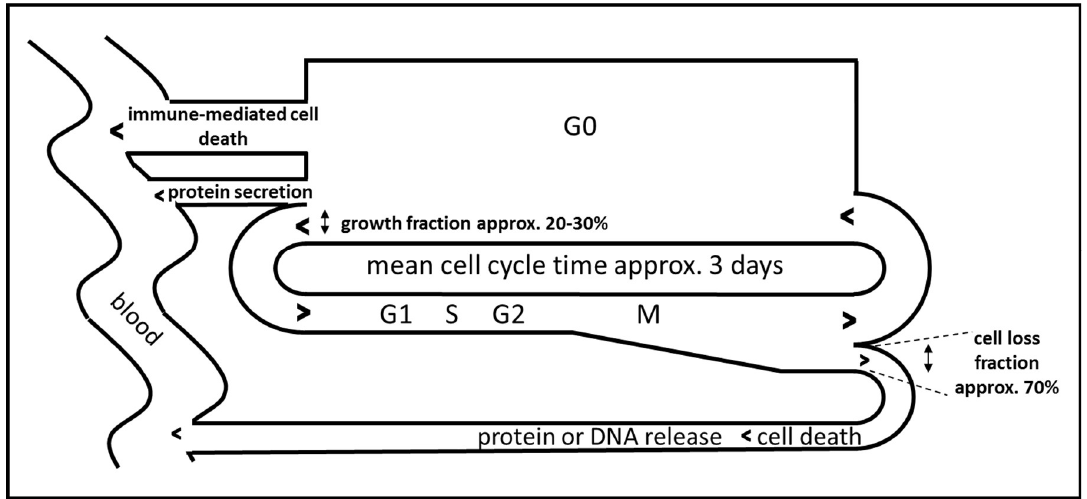
Figure 2. Idealized model of cell cycle-dependent immune-mediated release of biomarkers during immunotherapy of cancer, adapted from [32].